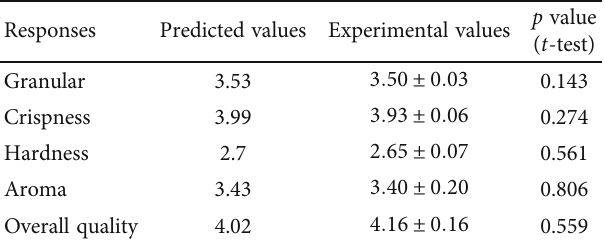
Table 5: Predicted and experimental values of the responses obtained at optimum conditions.